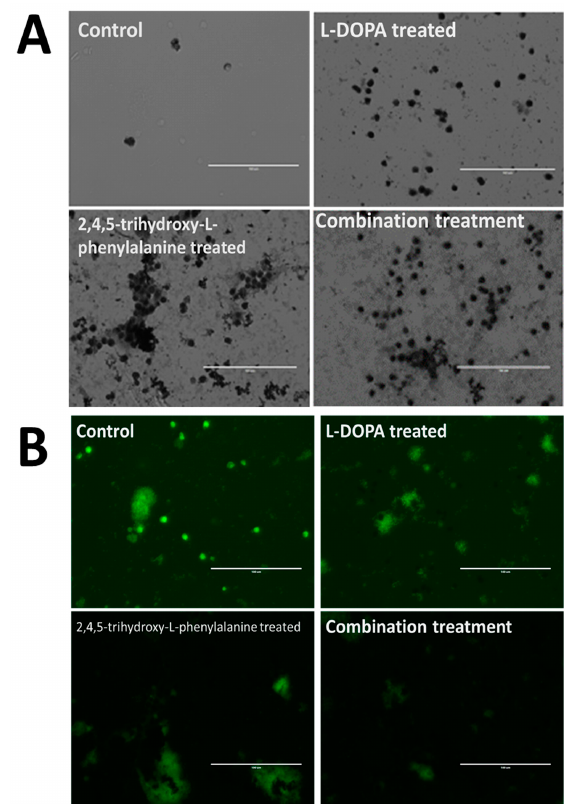
Figure 5. Incorporation of catecholamine polymers into neuromelanin granules following exposure to precursor molecules in cultured neurons. Rat fetal Substantia nigra tissue was purchased commercially and induced to form dopaminergic neural networks according to published procedures [5]. Addition of control bu ff er solution (panels A and B, upper left frame) is shown compared with additions of 50 uM levodopa ( l -DOPA; l -3,4-dihydroxyphenylalanine; Panels A and B; upper right frame) or 50 uM 6-hydroxy-levodopa (6-hydroxy l -DOPA; 2,4,5-trihydroxy- l -phenylalanine; Panels A and B; lower left frame) and a combination of both (panels A and B; lower right frame). Images were taken using an EVOS tabletop fluorescence microscope under visible light conditions (Panel A) or using the appropriate fluor filter (Panel B). Control cells are faint and di ffi cult to see under these conditions due to the lack of accumulated melanin. Levodopa, which is presumably decarboxylated rapidly to dopamine upon entering the cell through the membrane as a neutral zwitterion, caused the cells to display an initial shocked period during catecholamine polymerization and accumulation into NM granules, recovering to a healthy state over a period of weeks. The 6-hydroxydopamine counterpart to levodopa (2,4,5-trihydroxy- l -phenylalanine) displayed similar characteristics but resulted in a noticeably more darkened pigmented granule. Dopamine appears less localized in cells that have accumulated melanin, with this e ff ect being most pronounced in those cells treated with a combination of l -DOPA along with the 6-hydroxy